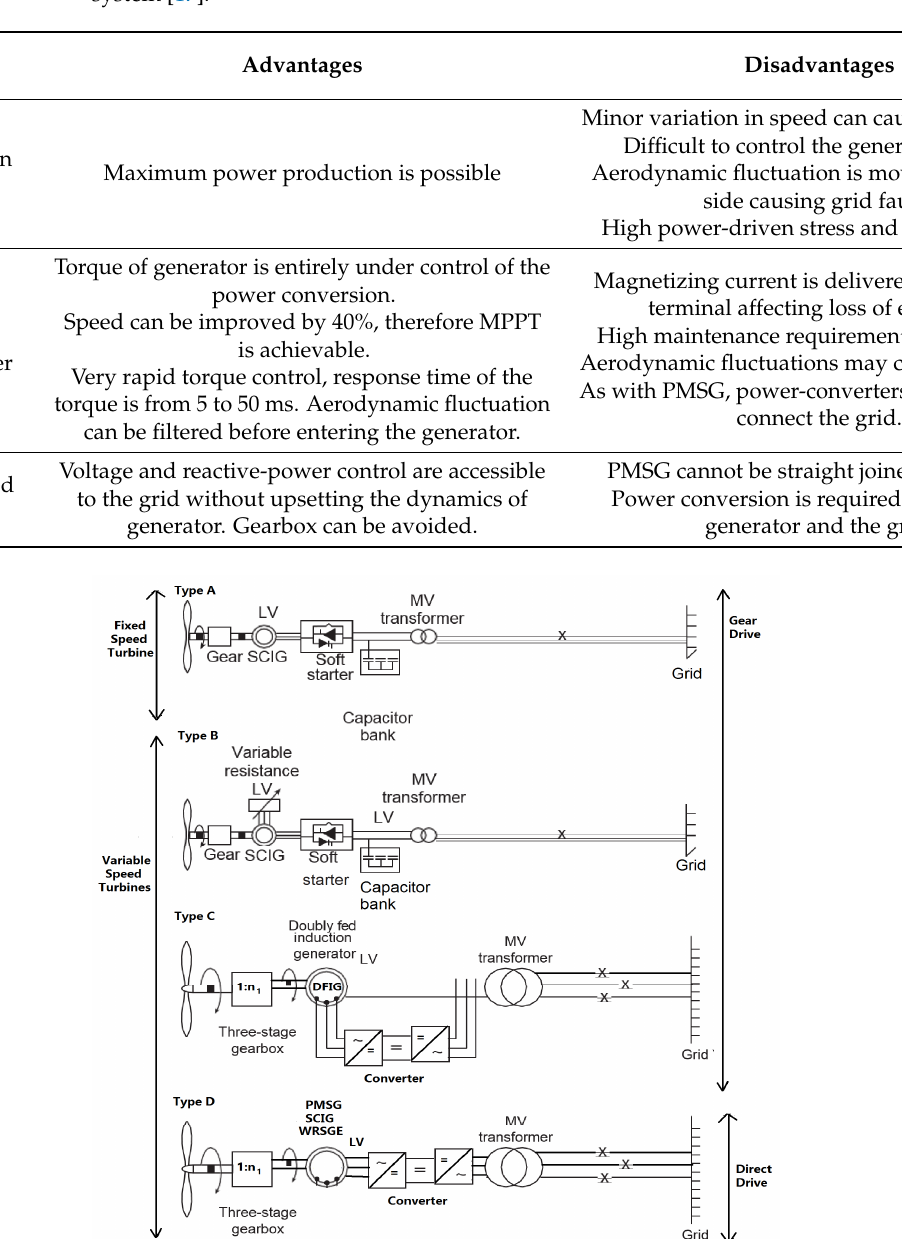
Table 1. The advantages and disadvantages of different wind generators with respective conversion